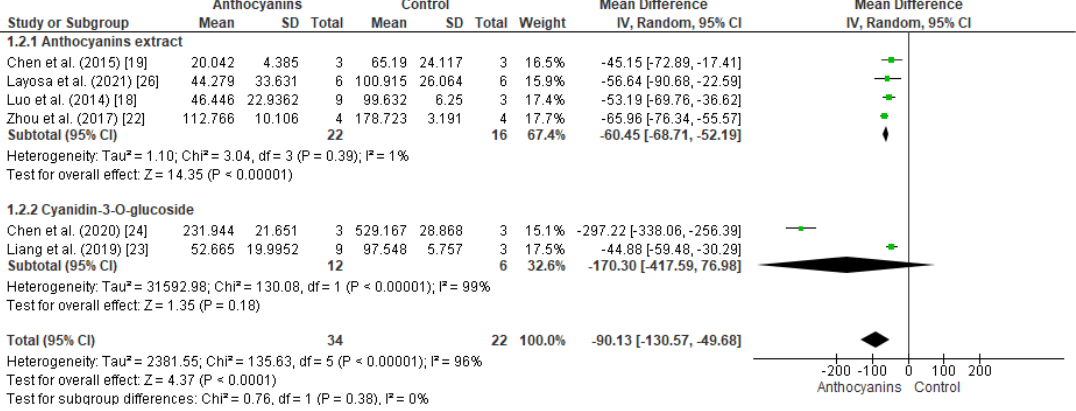
Figure 4. Forest plot of the meta-analysis comparing the anthocyanin-treated TNBC cell line versus the untreated controls in migration. The analysis was performed in subgroups, with four studies conducted with the anthocyanin-enriched extract and two studies evaluating isolated anthocyanin (cyanidin-3-O-glucoside). IV: inverse variance based on the mean difference; CI: confidence interval. The green box in the middle of each horizontal line represents the point estimate of the effect for each study (the larger the size of the green box, the greater the weight of the study). The black diamond represents the effect estimate of all meta-analysis studies. The position of the diamond indicates which group was significant in modulating the parameter (e.g., if the diamond is on the left side, it means that the anthocyanin group modulated the parameter. However, if the diamond touches the central vertical line, it means that there is no difference between control and anthocyanin groups) [18,19,22 – 24,26].